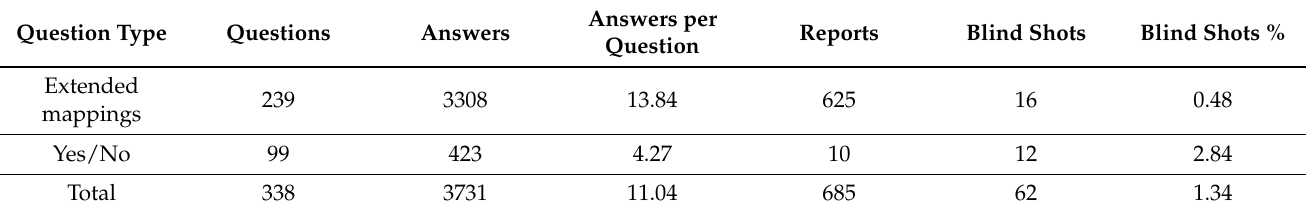
Table 1. Number of answers for different type of